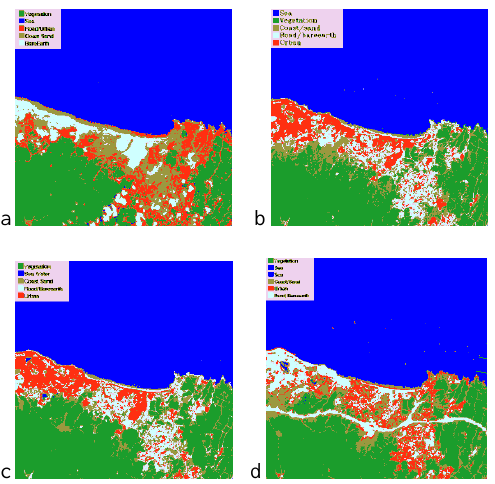
Figure 4: Landsat 5 TM a) 05/08/1986 b) 31/08/2007. Landsat 7 ETM c) 21 July 2001 and d) 28 July 2015.